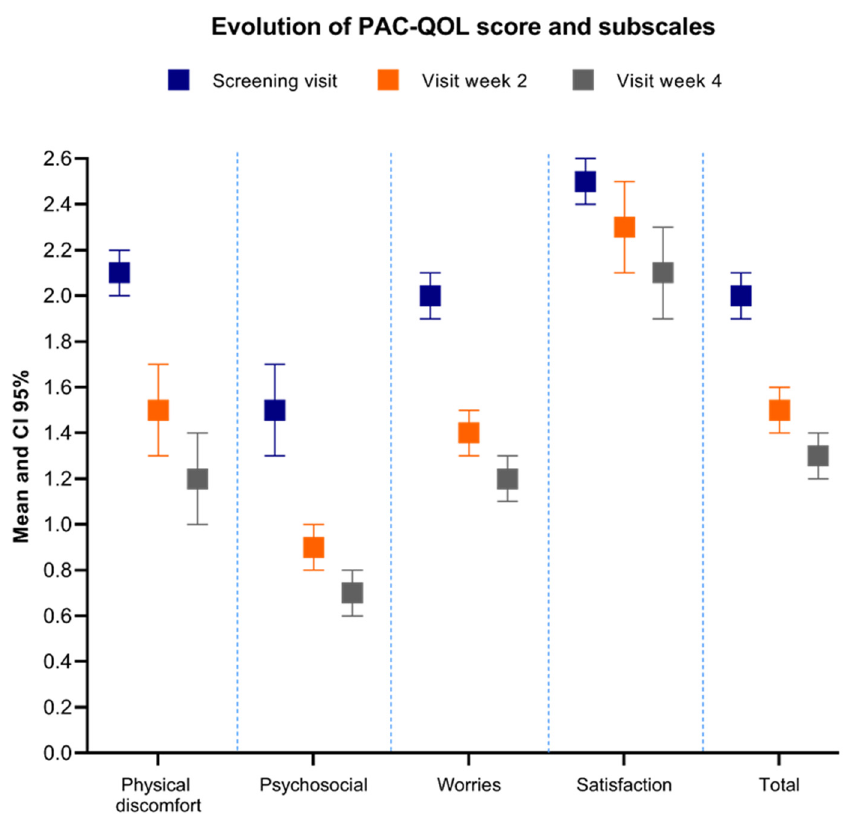
Figure 4. PAC-QOL changes throughout the study.